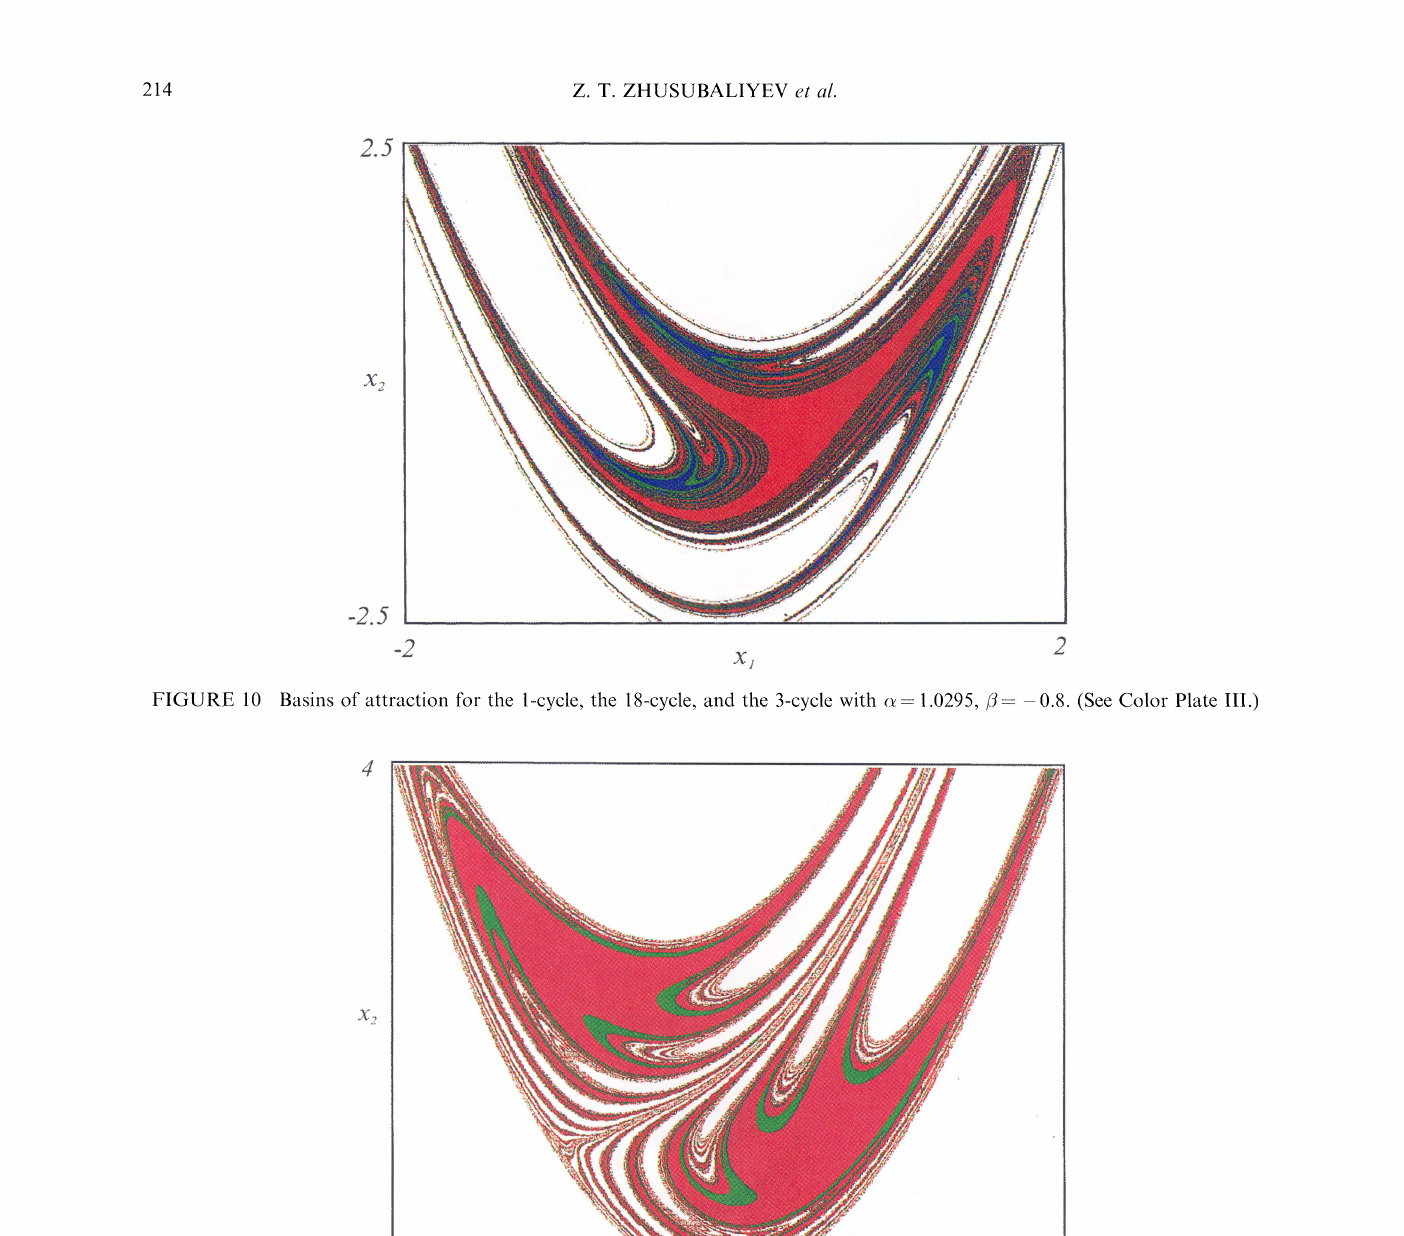
FIGURE Basins of attraction for the 2-cycle and the 8-cycle with c 0.53, /3= 0.88. (See Color Plate IV.) The location of X,k, k-- 1,m, are marked by that there are intervals within the limits of dots in Figures 9-11. The non-hatched parts of existence of the V,I where periodic motions Figures 9 and 10 correspond to the collection of coexist with chaotic